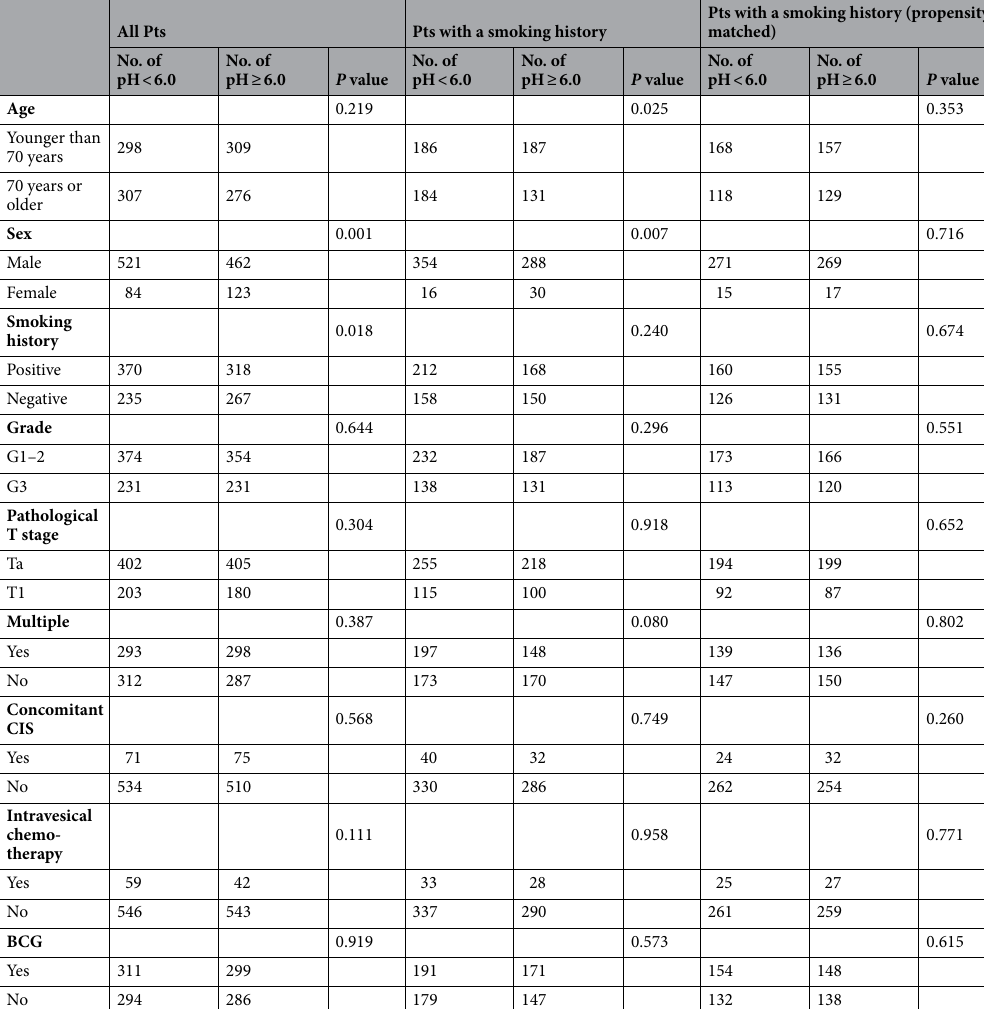
Table 3. Characteristics of all patients and those with a smoking history according to urinary pH levels after TURBT. NMIBC, non-muscle invasive bladder cancer; Pts, patients; No, number; CIS, carcinoma in situ; Chemo,